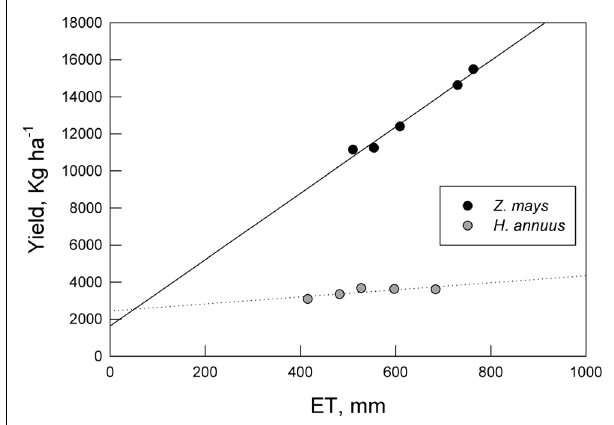
FIGURE 3 | Crop yield per harvest area and crop evapotranspiration (ET) for the same study shown in Figure 2.